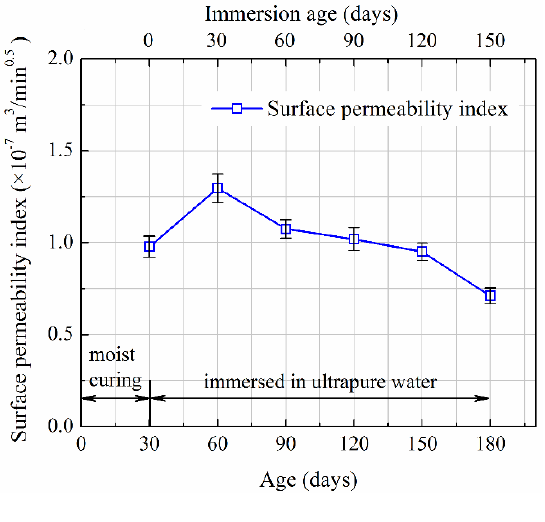
Figure 2. Evolution of surface permeability index of concrete as immersed in ultrapure water.